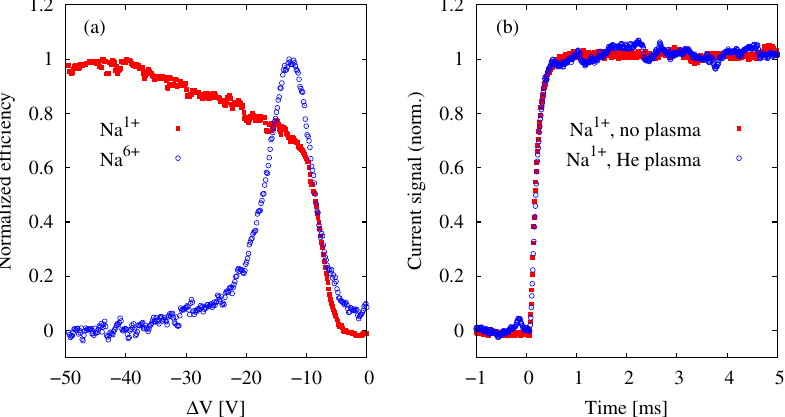
FIG. 1. (a) Normalized breeding efficiencies of 23 Na 1 þ and 23 Na 6 þ as a function of Δ V . (b) Time-resolved Faraday cup signals of 23 Na 1 þ with and without helium plasma in the charge breeder ( Δ V ¼ − 12 . 9